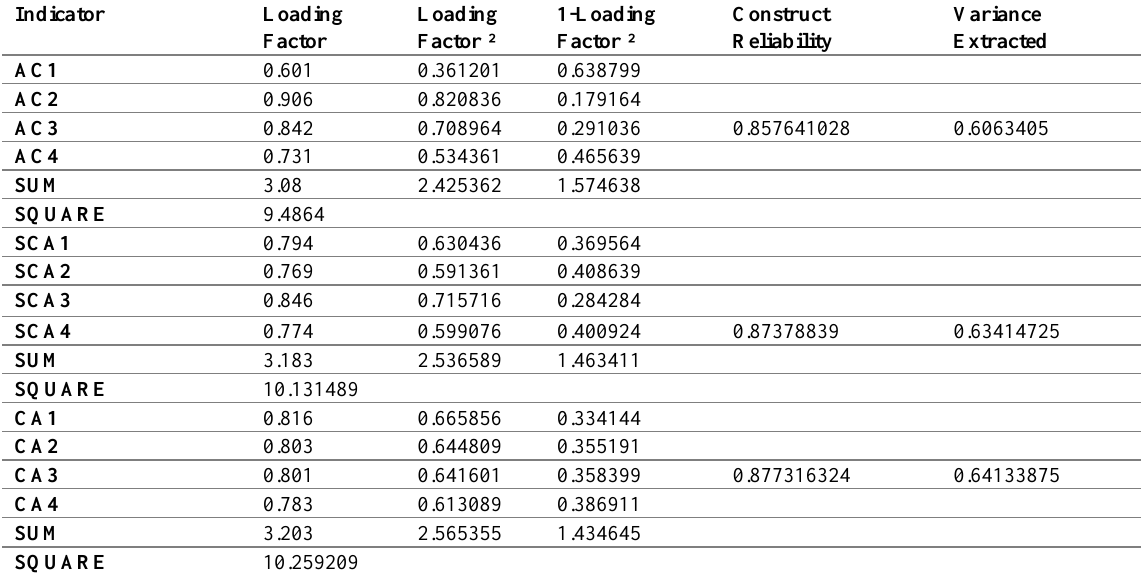
Table 5: Reliability testing